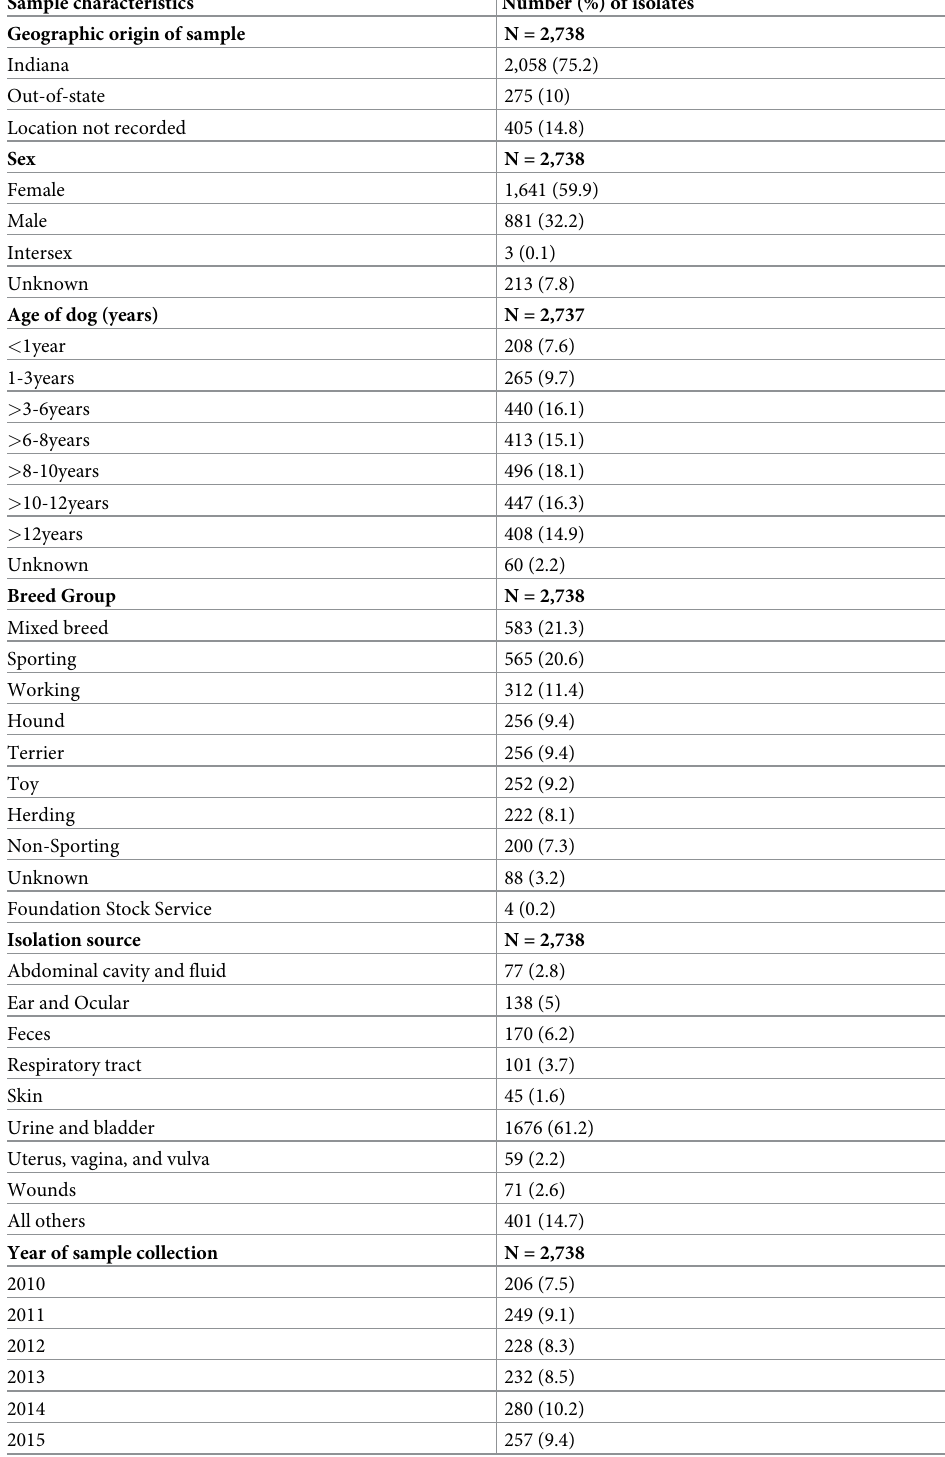
Table 1. Characteristics of all Escherichia coli isolates tested for antimicrobial susceptibility at the Indiana Animal Disease Diagnostic Laboratory, from January 2010 to December